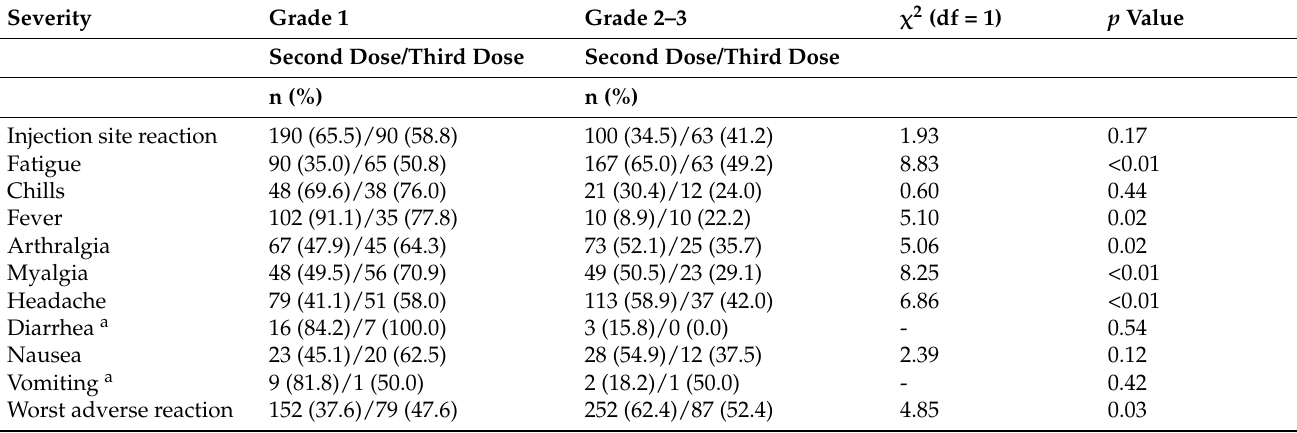
Table 4. Comparison of second and third doses of BNT162b2 for mild and moderate to severe adverse reactions.